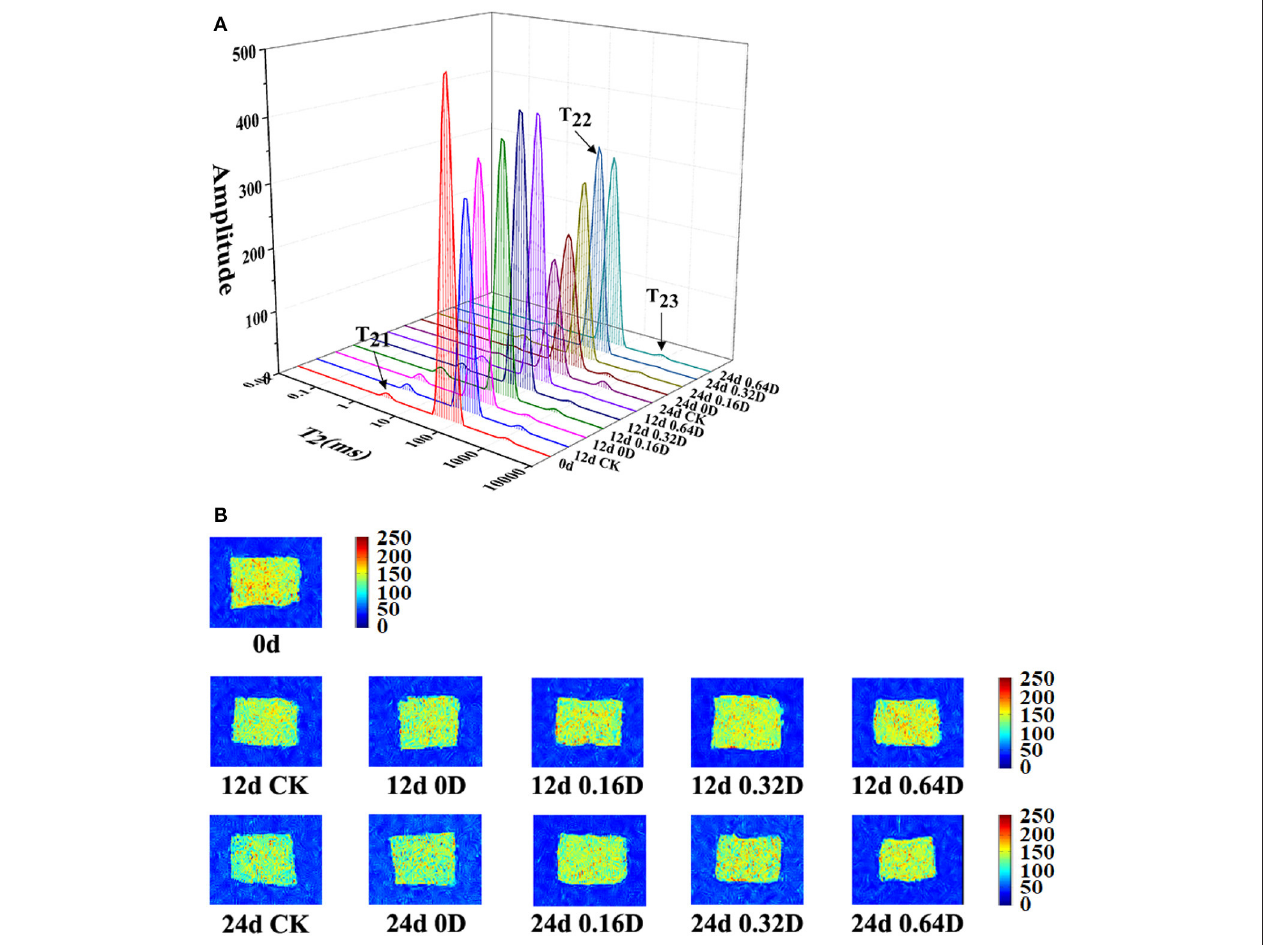
FIGURE 4 | Changes in (A) water distribution and (B) magnetic resonance imaging of turbot samples during the refrigerated storage [CK, washed with deionized water; 0D, immersed in weakly acidic electrolytic water (WAEW) for 10min, followed by a coating with a locust bean gum–sodium alginate (LBG-SA)-active coating; 0.16D, immersed in WAEW for 10min, followed by coating with LBG-SA coating with 0.16 g/L daphnetin; 0.32D, immersed in WAEW for 10min, followed by coating with LBG-SA coating with 0.32 g/L daphnetin; 0.64D, immersed in WAEW for 10min, followed by coating with LBG-SA coating with 0.64 g/L